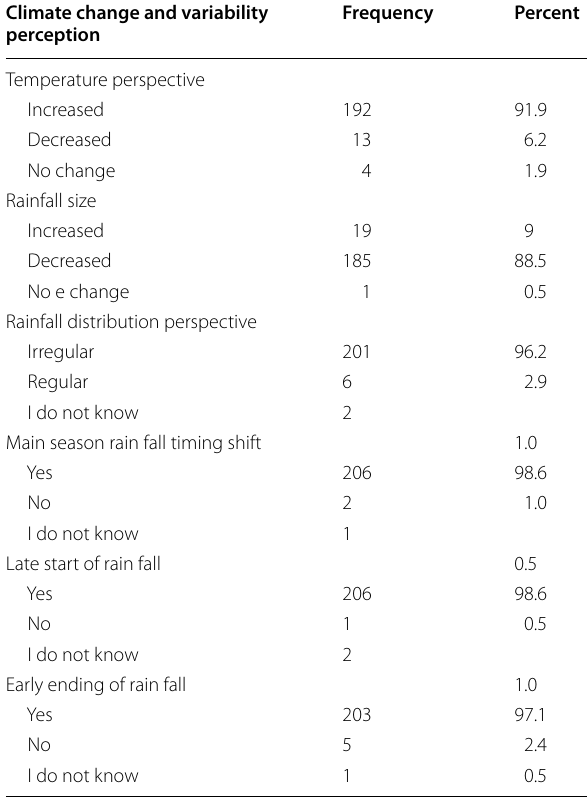
Table 2 Sample respondents’ perception of climate change from temperature and rainfall